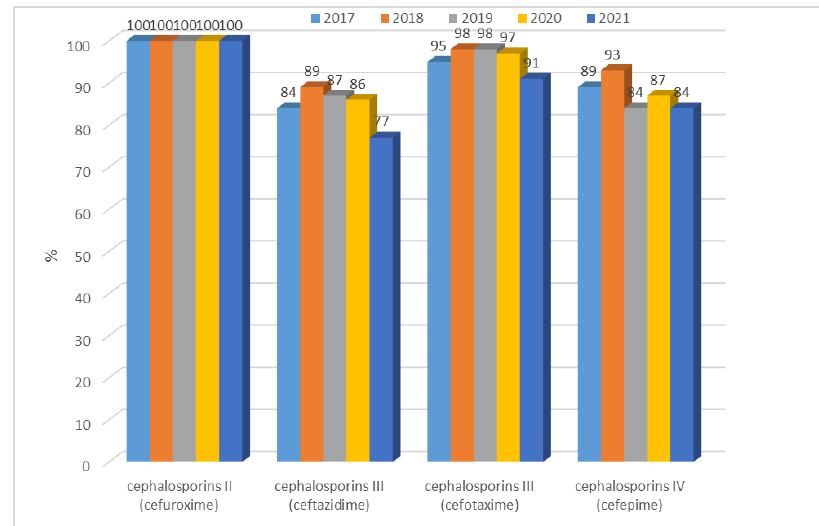
Figure 5. Percentage of cephalosporin-resistant E. coli ESBL(−) strains.